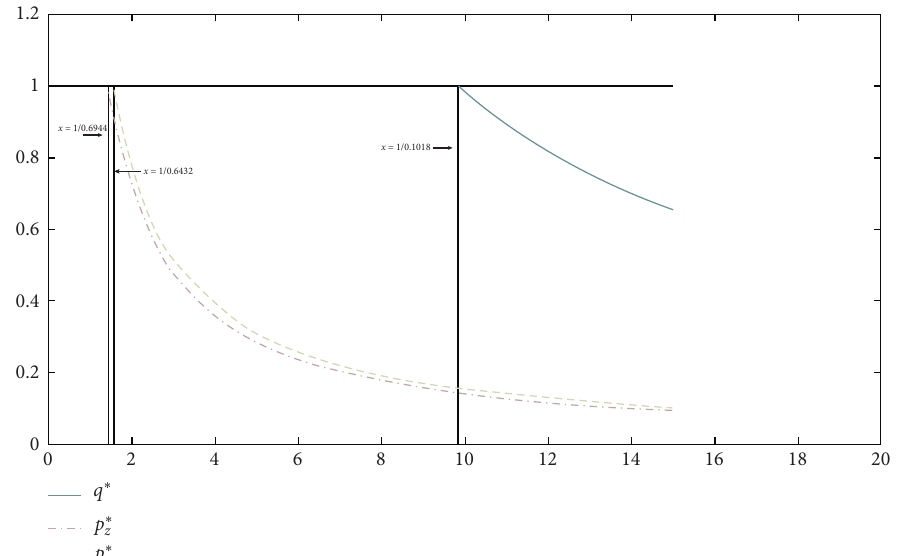
Figure 6: Simulation diagram of the impact of verification success rate on optimal rent-seeking probability and optimal supervision